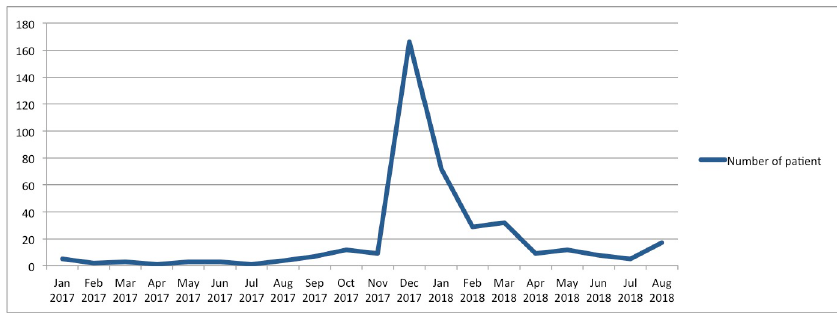
Fig 1. Diphtheria cases admitted to hospital by